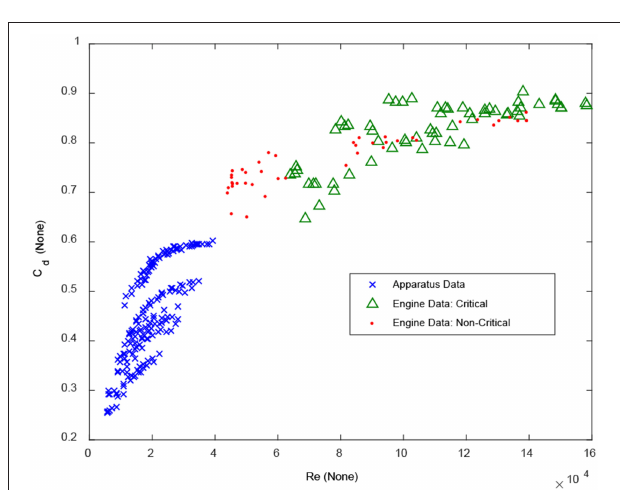
FIGURE 10 | Random Error, Systematic Error and Net Uncertainty for the ten repeat points.